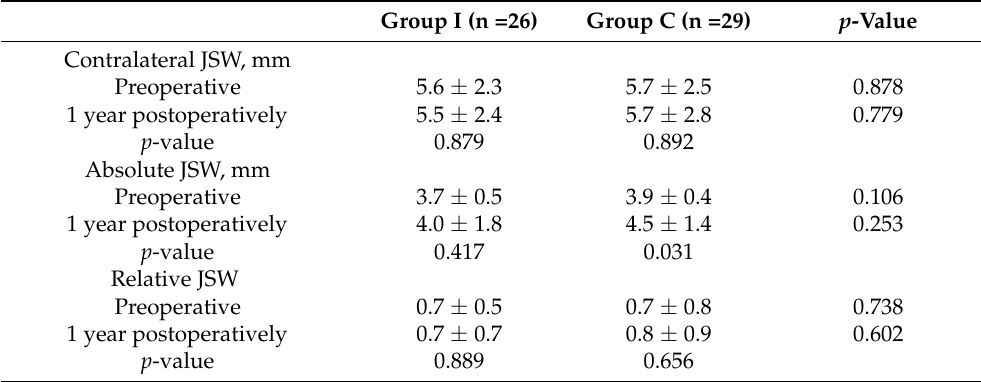
Table 5. Changes in Joint Space Width of Lateral Edge on Rosenberg